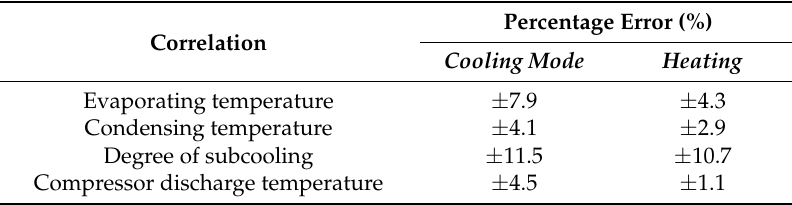
Figure 32. Comparison between experimental and predicted RCR in heating mode at T OD of ( a ) − 5 ◦ C, ( b ) 0 ◦ C, ( c ) 5 ◦ C and ( d ) 10 ◦ C. Table 6. Error thresholds.